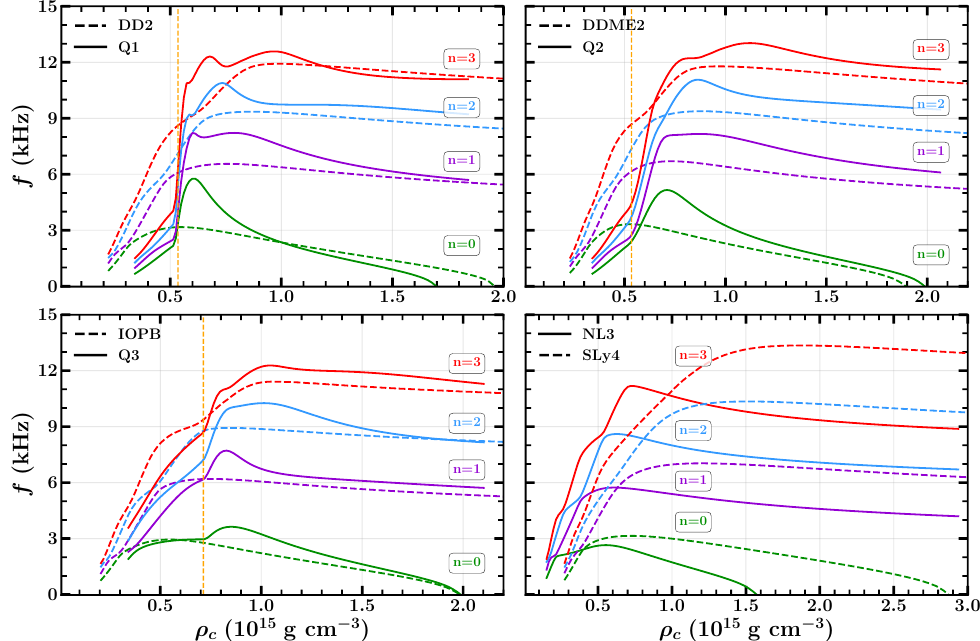
Figure 4. The first four radial modes as a function of the central density. In the first three plots, we compare a hadronic EoS with a quarkyonic one, and, in the last one, we compare the stiffest hadronic EoS NL3 with the softest SLy4. The vertical orange line in the first three plots marks the transition density ( n t ) for the respective quarkyonic EoSs indicating the sudden change in